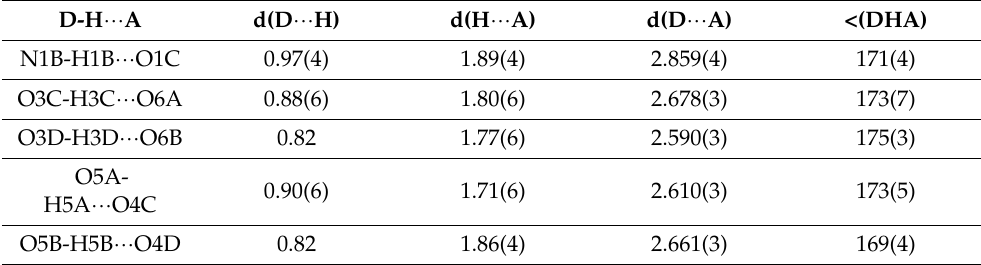
Figure 4. Molecular packing in the crystal structure of DNSPA: ( a ): 12-molecule aggregate supra- molecular tape linked by indole-N-H ⋯ O(sulfonyl) (magenta dotted lines) and indole-N-H ⋯ O(p- nitrophenyl) (orange lines) and sustained by a bunch of carboxyl-O-H ⋯ O(carboxyl) (blue), indole- N-H ⋯ N(Sulfanamide) (yellow) and indole-N-H ⋯ O(carbonyl) (green) interactions. ( b ) molecular aggregation and crystal packing along the b-axis. Table 1. Hydrogen bond geometry (Å, °) .